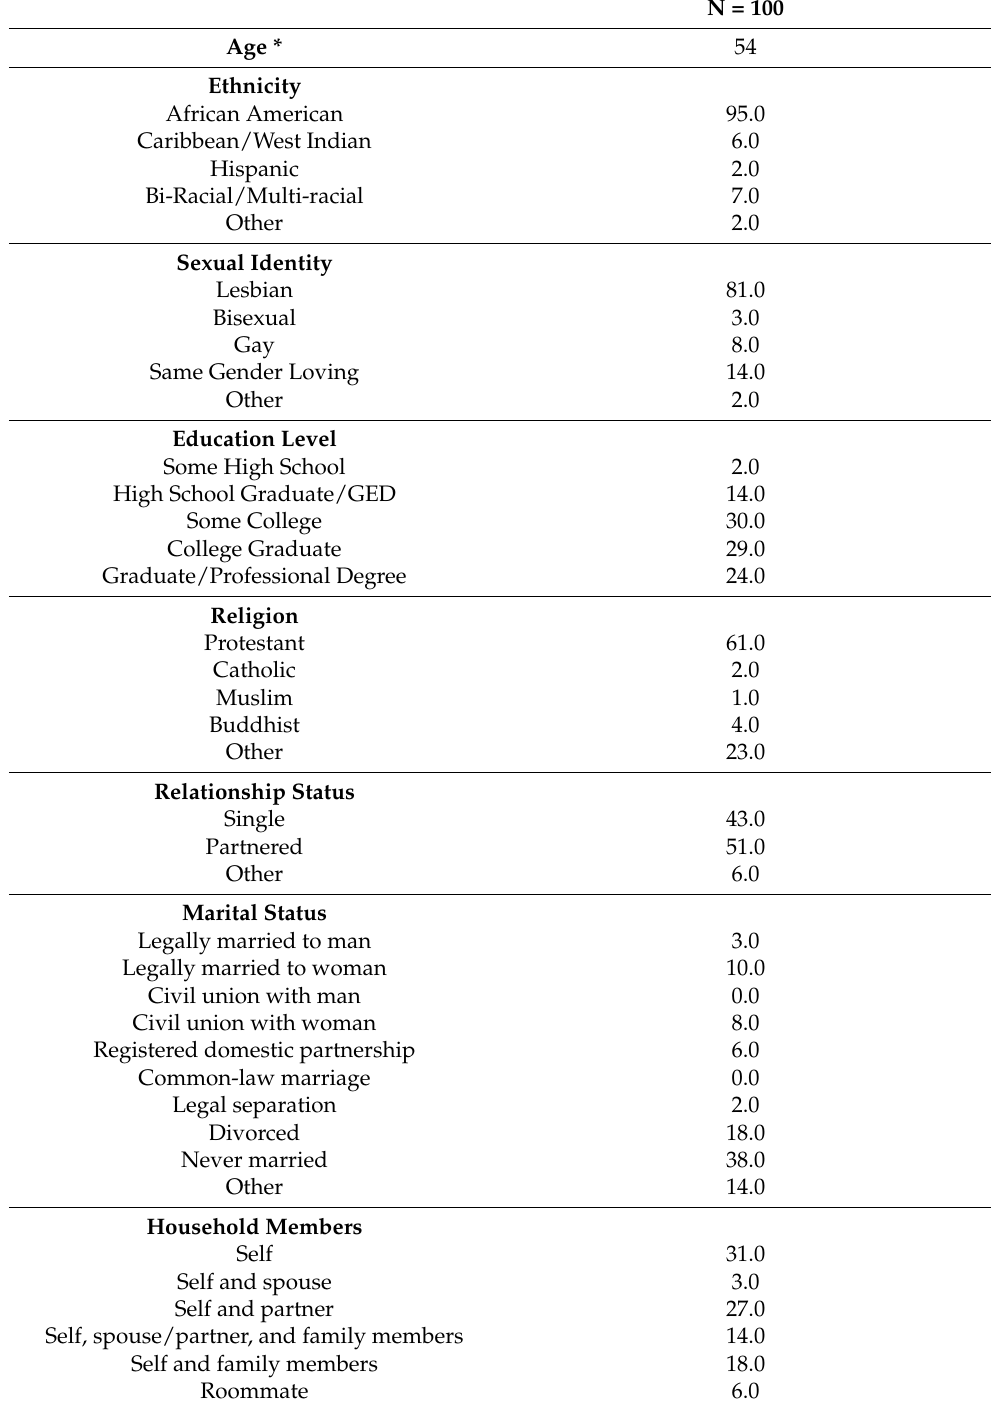
Table 1. Demographics of